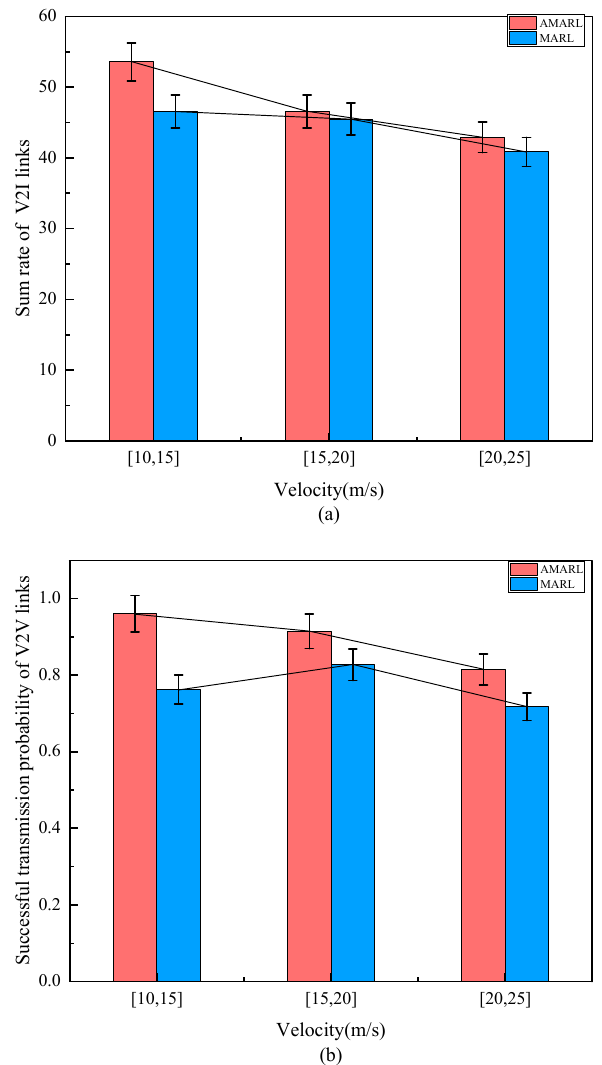
Figure 8. The performance comparison between AMARL and MARL: ( a ) Sum rate of V2I links. ( b ) Successful transmission probability of V2V links.